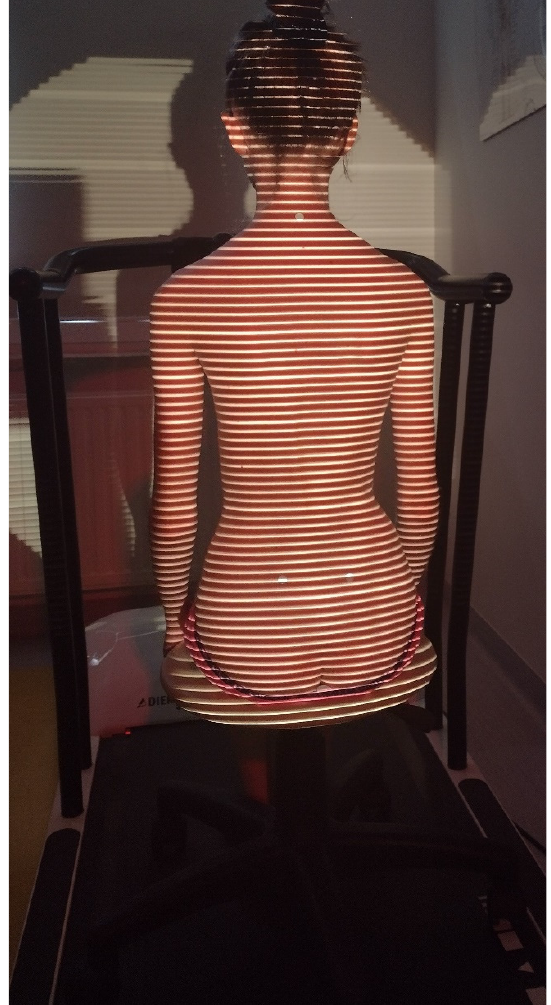
Figure 3. DIERS Formetric Measurement.